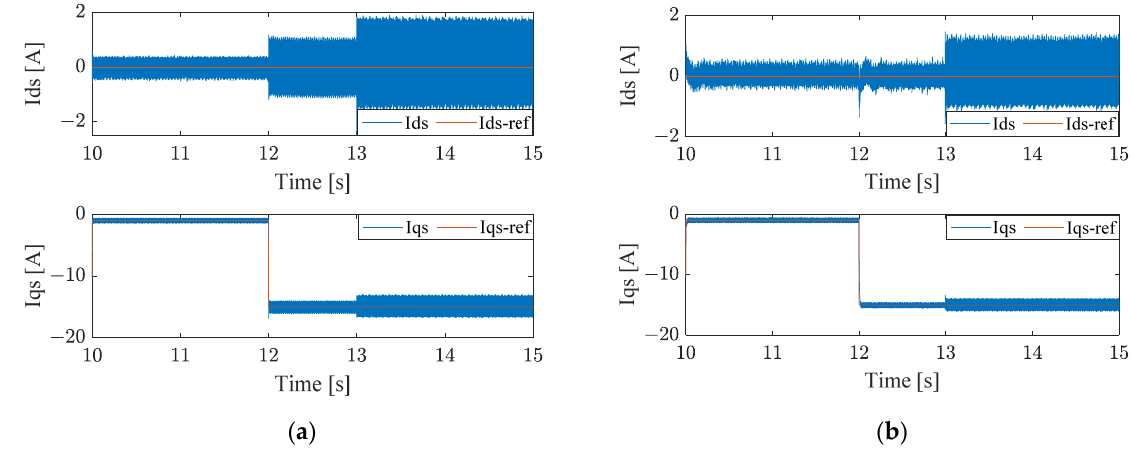
Figure 9. Faulty mode results: ( a ) dq currents with PI controller; ( b ) dq currents with FLC.